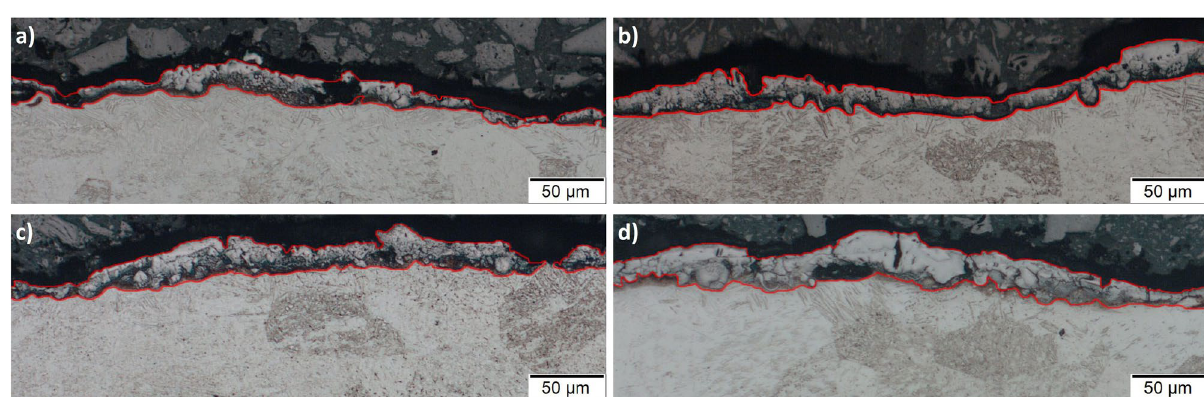
Figure 9. Main Effects Plot and Interaction Plot of AWLT.